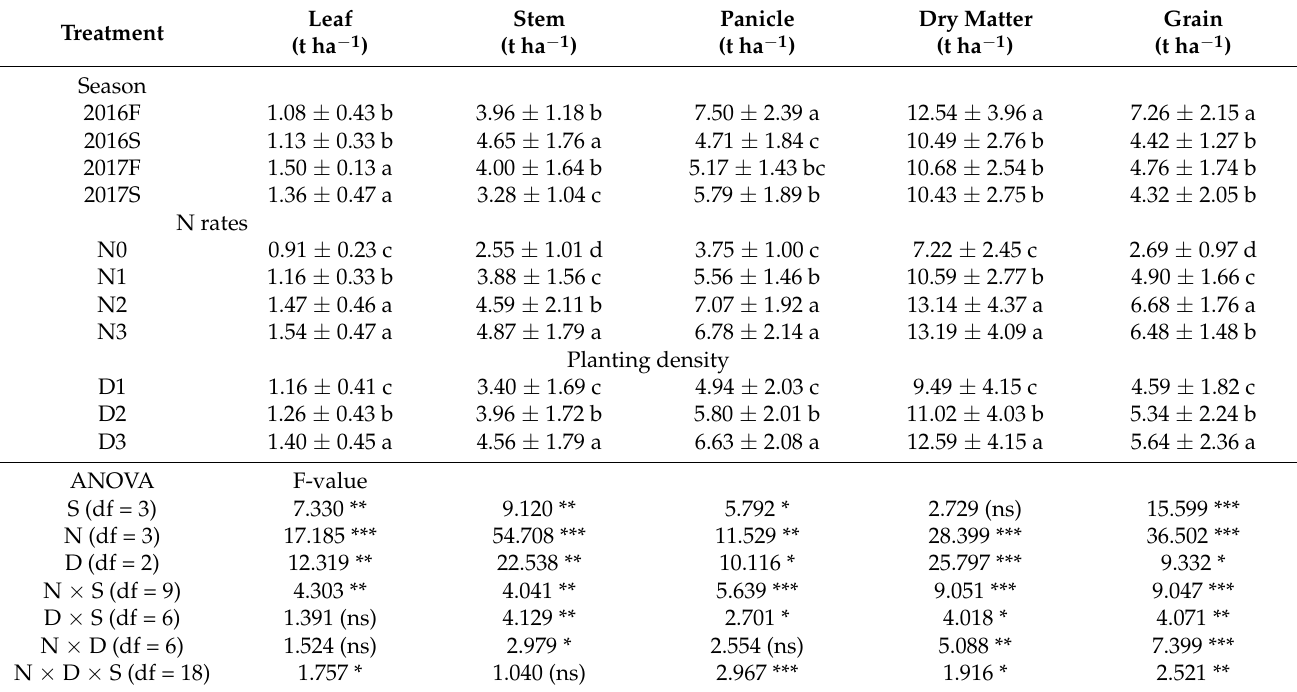
Table 1. Dry matter accumulation of perennial rice under different N rates and planting densities over four seasons of